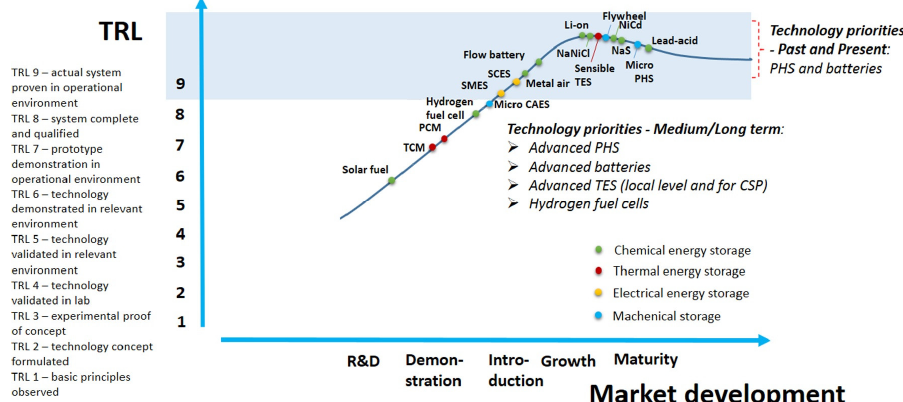
Figure 11. Overview of the maturity of energy storage technologies (Thermo-Chemical Materials (TCMs), phase change materials (PCMs), superconducting magnetic energy storage (SMES), super capacitor energy storage (SCES), sodium nickel chloride (NaNiCl) batteries, thermal energy storage (TES), nickel cadmium (NiCd) batteries, sodium sulphur (NaS) batteries, and pumped hydro storage (PHS)) as of 2017 with technology readiness level (TRL) on the y-axis and market development on the x-axis [120].